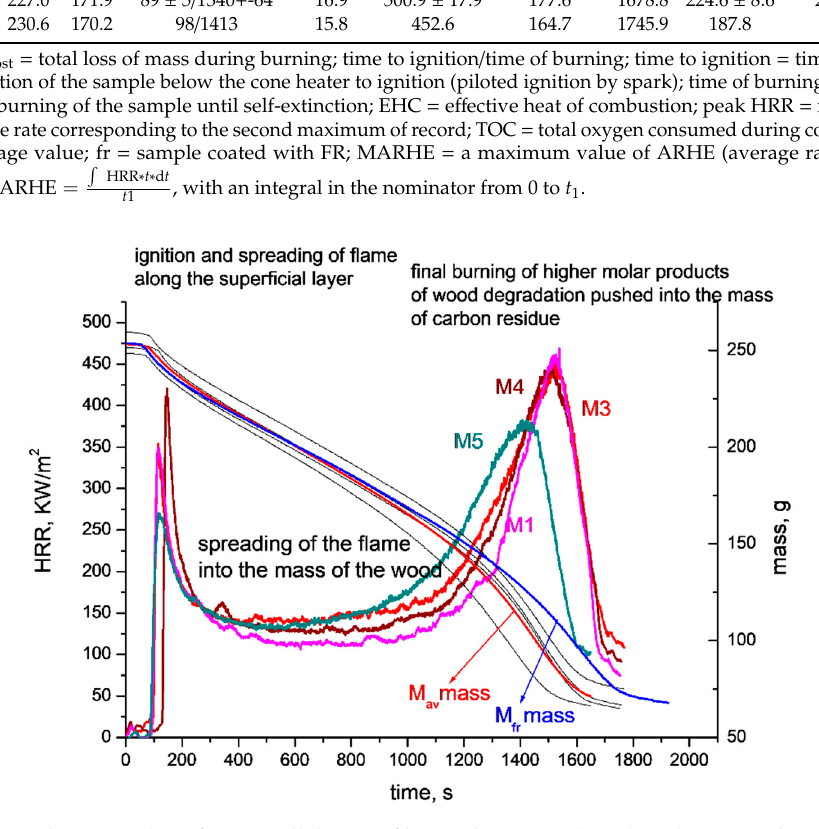
Figure 4. Merbau sample in four parallel runs of heat release rate (HRR) and mass with time. Cone radiancy is 35 kW/m 2 ; M av mass is the average mass change of samples M 1 , M 3 , M 4 , and M 5 .